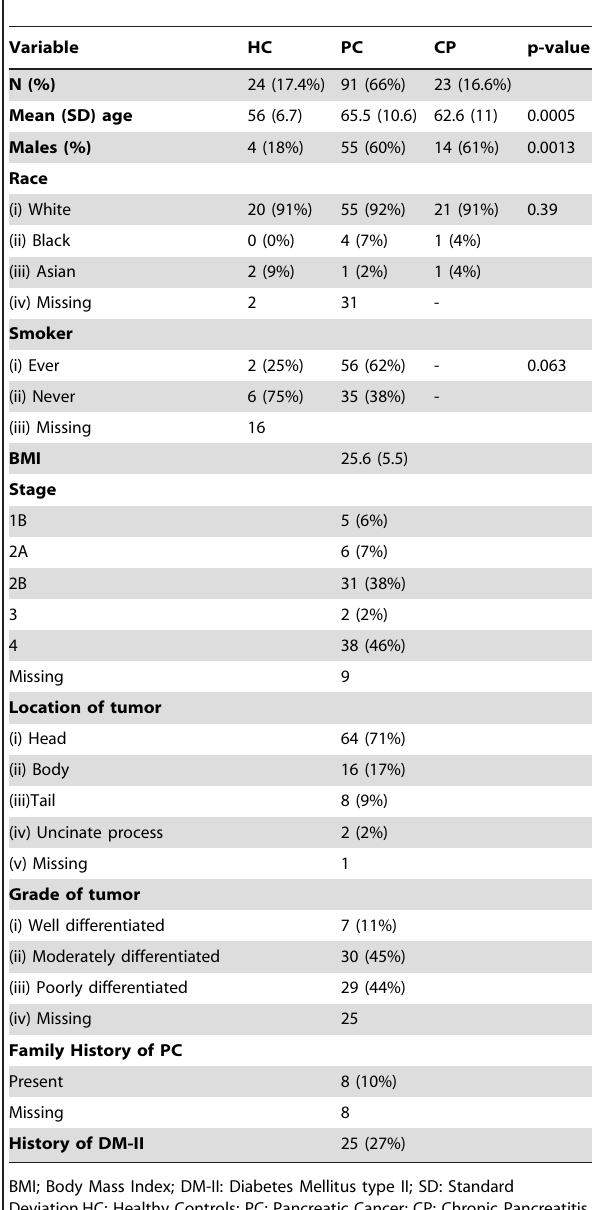
Table 1. Demographics and clinicopathologic characteristics of patients included in the